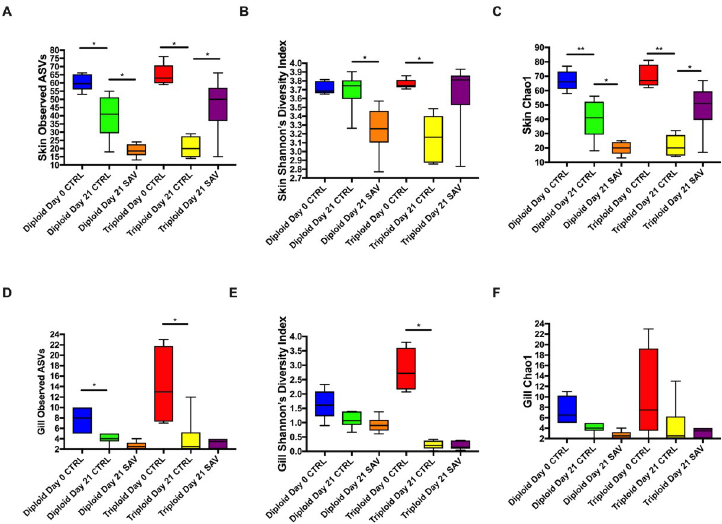
Fig 3. Alpha diversity metrics for the skin and gill microbiome of triploid and diploid control and infected Atlantic salmon. (A) Total number of observed ASVs in the skin. (B) Shannon’s diversity index in the skin. (C) Chao1 index in the skin. (D) Total number of observed ASVs in the gills. (E) Shannon’s diversity index in the gills. (F) Chao1 index in the gills.